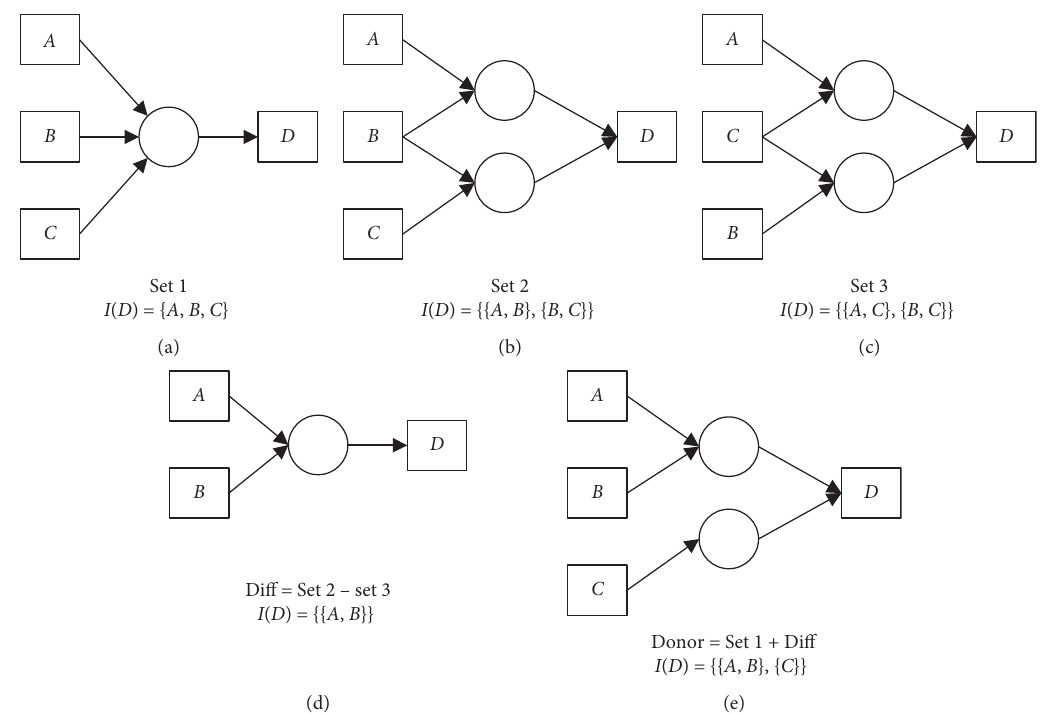
Figure 3: Illustrating example of the differential mutation operators.